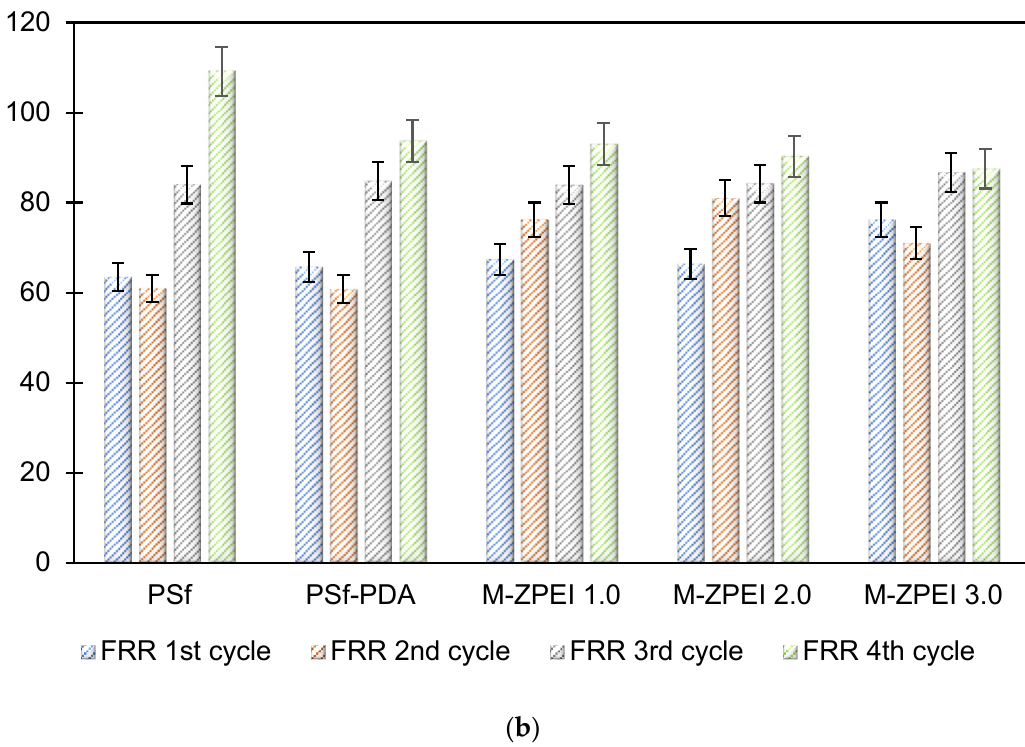
Figure 8. ( a ) Water flux profile of prepared membranes at in four filtration cycles; and ( b ) FRR values of all prepared membrane after four cycles.